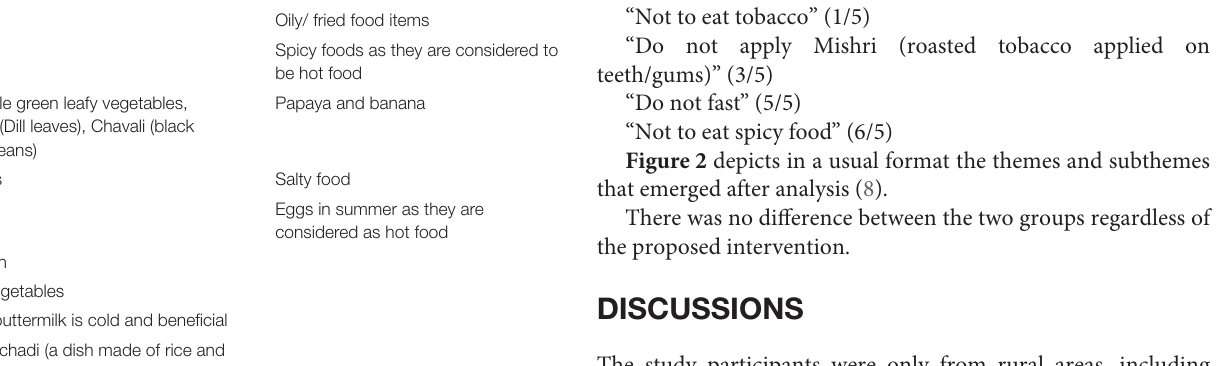
TABLE 4 | Perceptions of women about food items during preconception and pregnancy. Must eat food